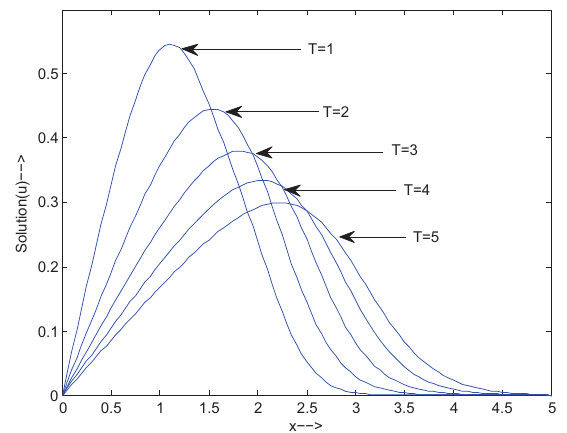
Fig. 7: Example 4: Solution profiles for T ≤ 5 , ν = 0.1 , Δt = 0.001 and Δx = 0.05 .